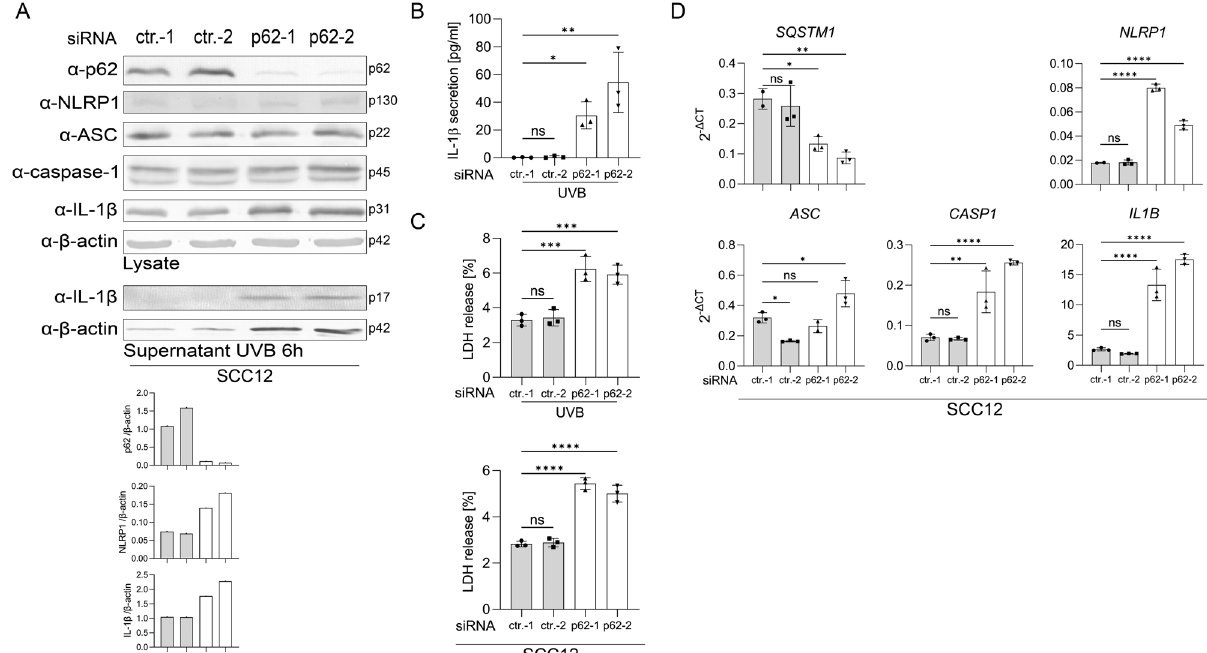
Fig. 2 Knockdown of p62 expression rescues in fl ammasome activation in SCC12 cells. A – C SCC12 cells were transfected with two different control siRNAs (ctr.-1, ctr.-2) or two different siRNAs targeting p62 mRNA (p62-1, p62-2). A Western blots of lysate of mock-treated transfected SCC12 with a quanti fi cation of the band corresponding to p62, NLRP1, and IL1 β normalized to β -actin (lower panel), and of supernatant 6 h after UVB irradiation. B IL-1 β in the supernatant 6 h after UVB irradiation determined by ELISA. C LDH release 6 h after UVB irradiation (upper panel) or after mock-treatment. D mRNA expression of the indicated genes determined by qPCR in mock-treated cells. Data are represented as mean ± SD of three experiments using one-way analysis of variance with Dunnett ’ s multiple comparison test ( N = 3) ( B – D ) or are representative of at least three independent experiments ( A ). (**** P < 0.001, *** P ≤ 0.001, ** P ≤ 0.01, and * P ≤ 0.05, ns = not signi fi